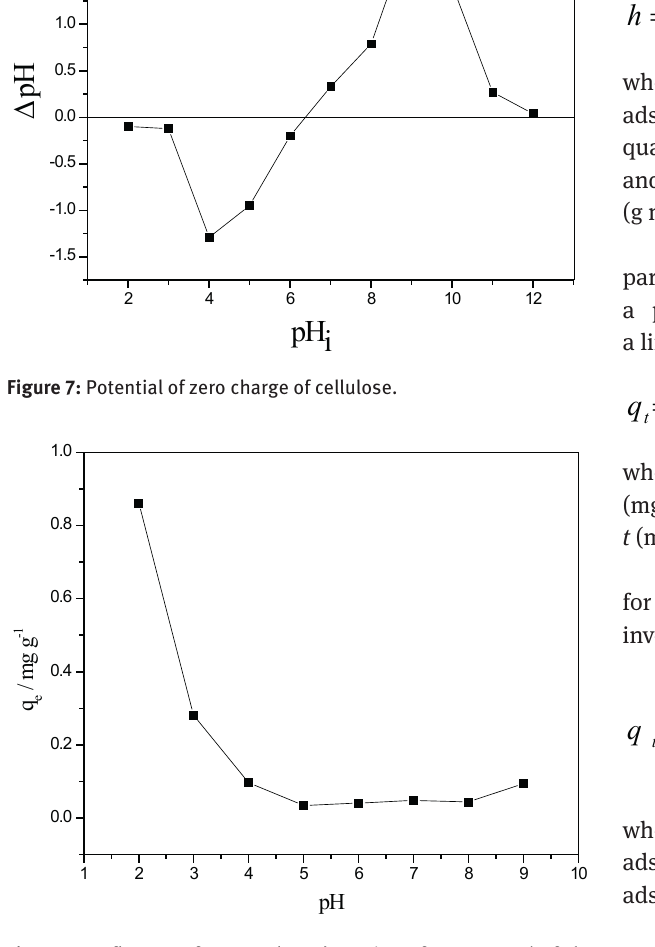
Figure 8: Influence of pH on the adsorption of 30.0 mg L -1 of the reactive red RB dye in cellulose, T =